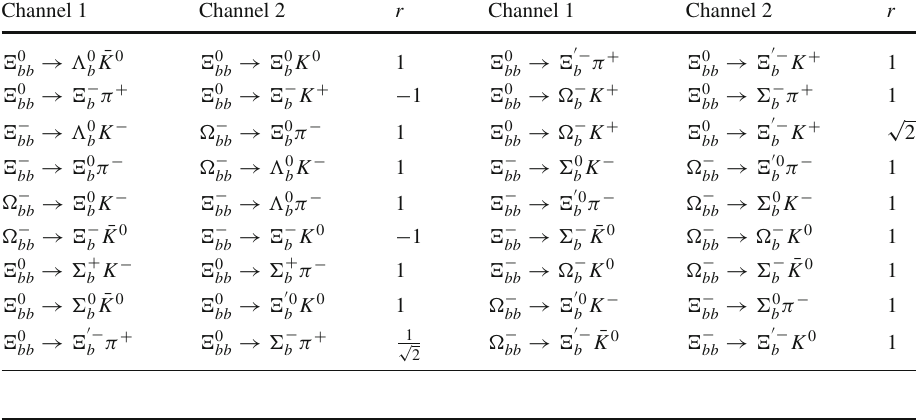
Table 22 U-spin relations for (cid:2) ,(cid:5) bb bb decays into a bottom meson and a light baryon. Results in the “channel 1” are for b → d processes and the ones in the “channel 2” are for b → s processes. r denotes the ratio of the two amplitudes